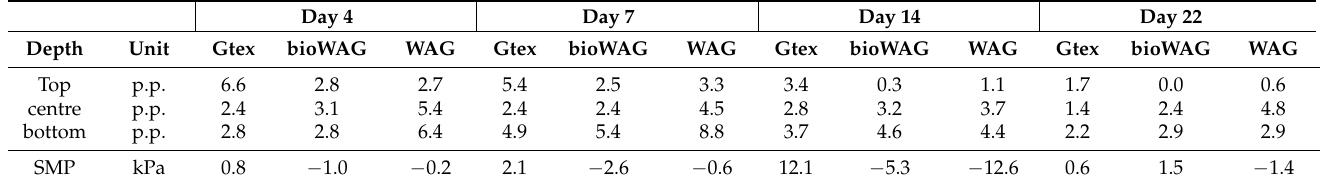
Table 6. Differences in mean soil moisture and mean soil matric potential between treated pot sample and control sample. Day 4 Day